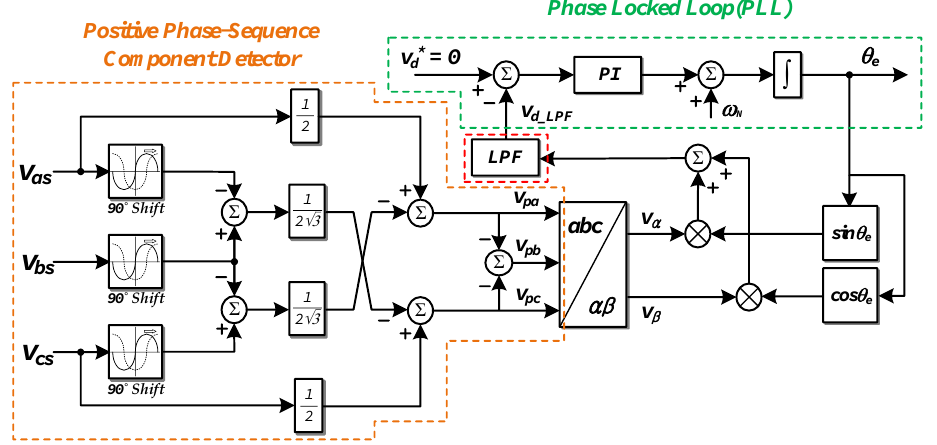
Figure 5. Control block diagram of positive sequence voltage and phase detector.